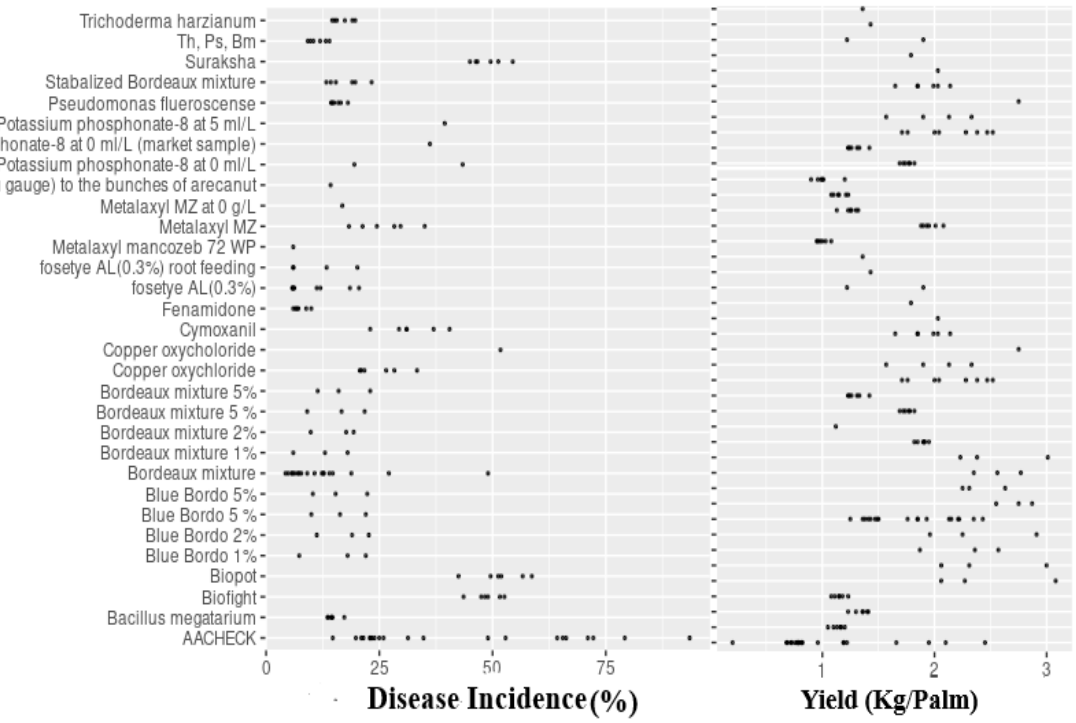
Figure 2. Treatment mean values (points) of FRD incidence and arecanut yield (Kg/Palm). AA-CHECK = untreated control, with treatments tested at different concentrations. Th = Trichoderma harzianum ; Ps = Pseudomonas fluorescence ; Bm = Bacillus megatarium .